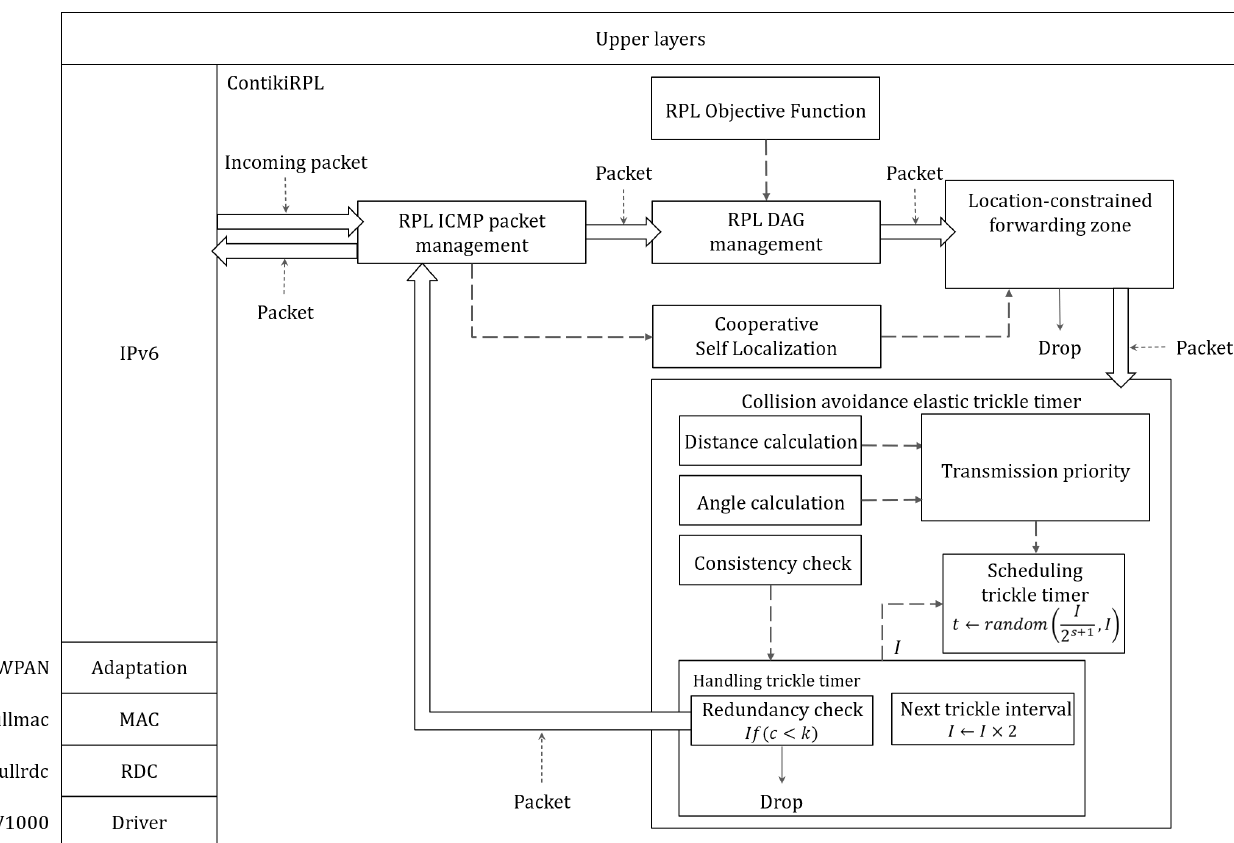
Figure 6. The software architectureof Collision Avoidance Geographic P2P-RPL on Contiki